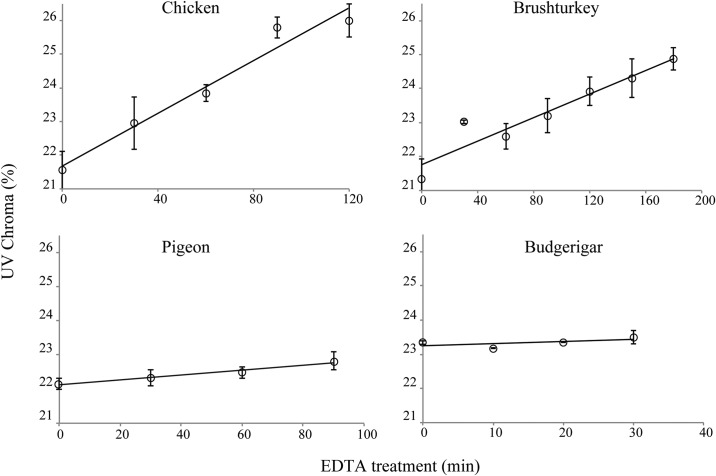
UV-chroma as a function of the duration of EDTA treatment. The data are presented as means±s.e.m. Note that the x-axis scales are different for each species.